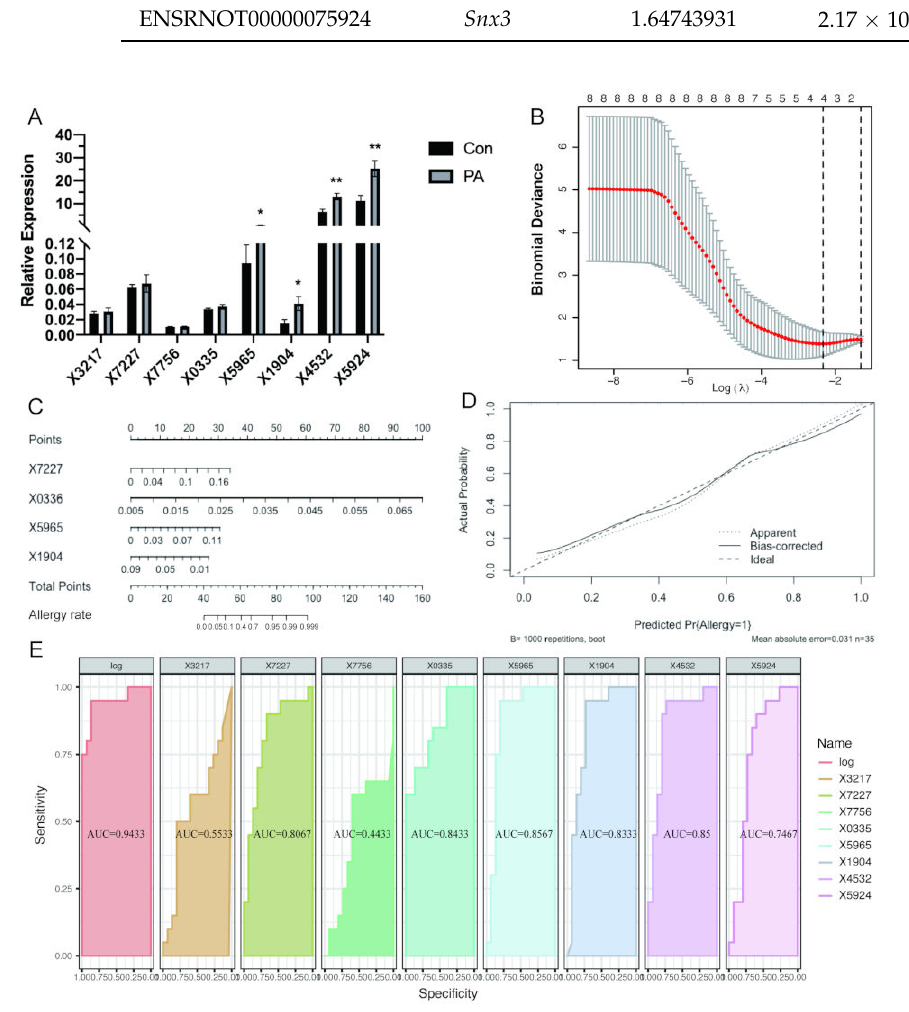
Figure 3. Construction of diagnostic model based on lncRNAs. ( A ) The expression levels of eight candidate lncRNAs verified by qRT-PCR (N Con = 18, N PA = 23). ( B ) LASSO analysis showed that four lncRNAs were associated with PA in the training set. ( C ) A nomogram to predict the probability of peanut allergy based on logistic regression. ( D ) Calibration curve for the constructed logistic regression equation. ( E ) Performance of individual candidate lncRNAs and four-lncRNA panel as biomarkers for PA exhibited by the receiver operating characteristic (ROC) curves in the training set (N = 3). * p < 0.05, ** p < 0.01 (compared to the control